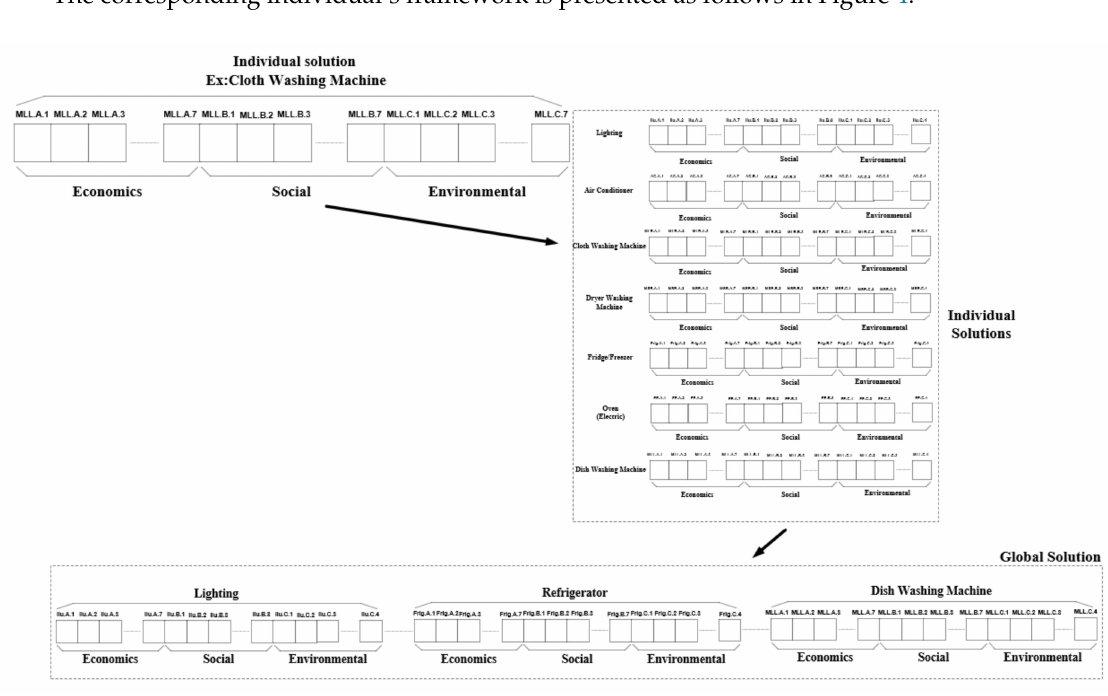
Figure 4. Individual